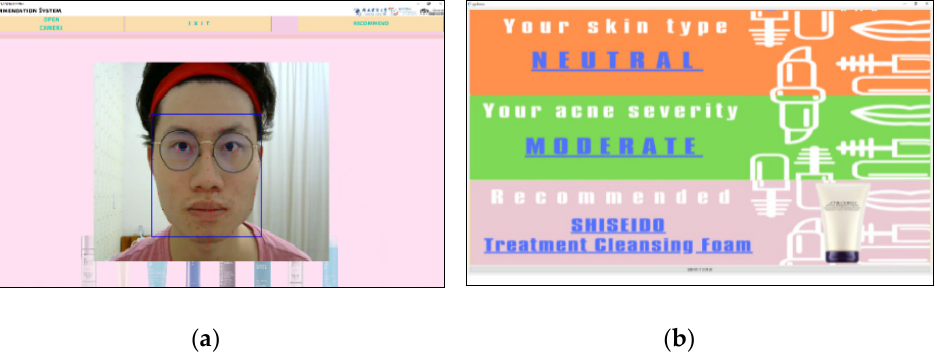
Figure 6. Skincare products’ recommendation system: ( a ) Detection interface; ( b ) Result interface.